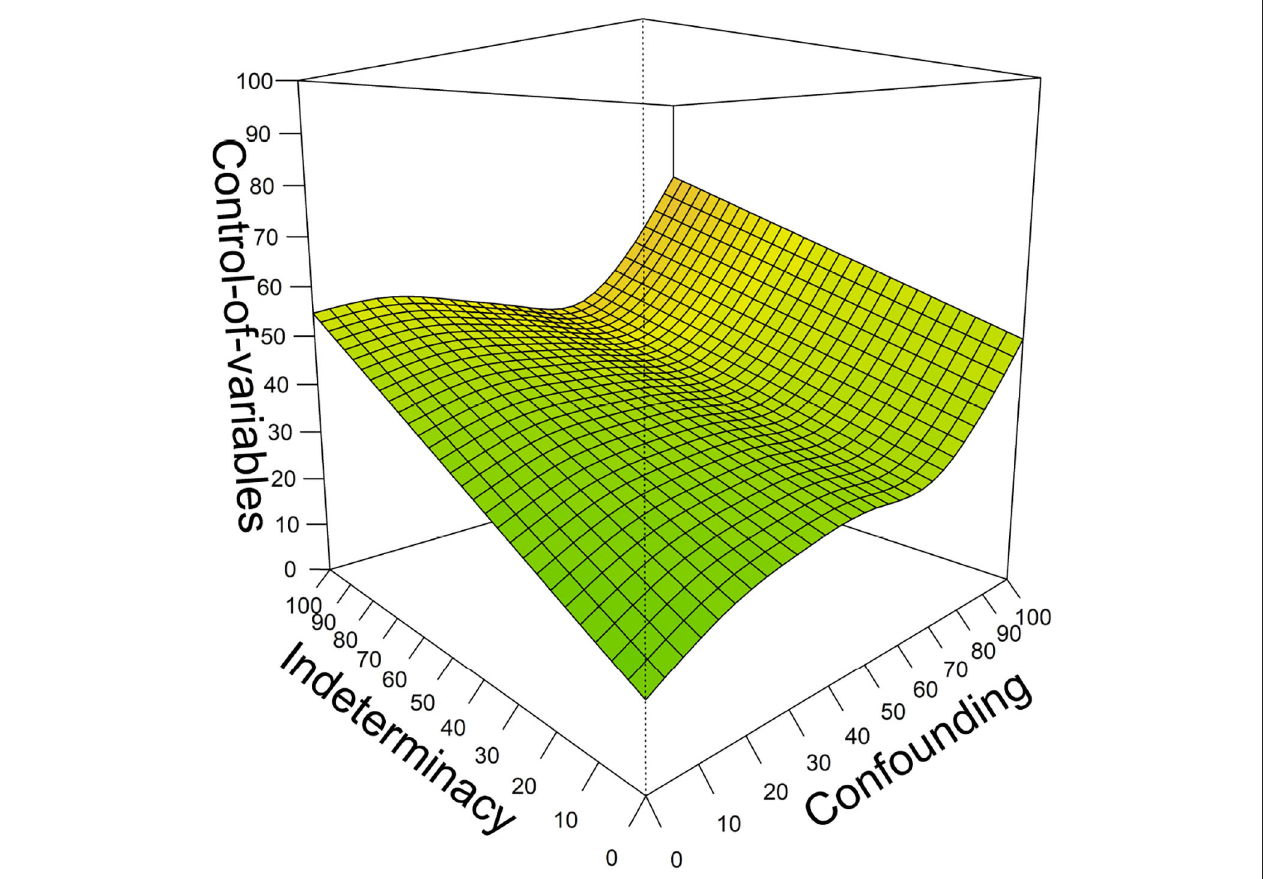
FIGURE 5 | The prediction of children’s mastery of CVS from their understanding of indeterminacy and confounding 2 years earlier. All axes indicate model estimates of percentage of solved items on the respective measure. Areas in darker green indicate lower predicted later CVS skill, areas in brighter green moderate, and in orange highest later CVS skill.